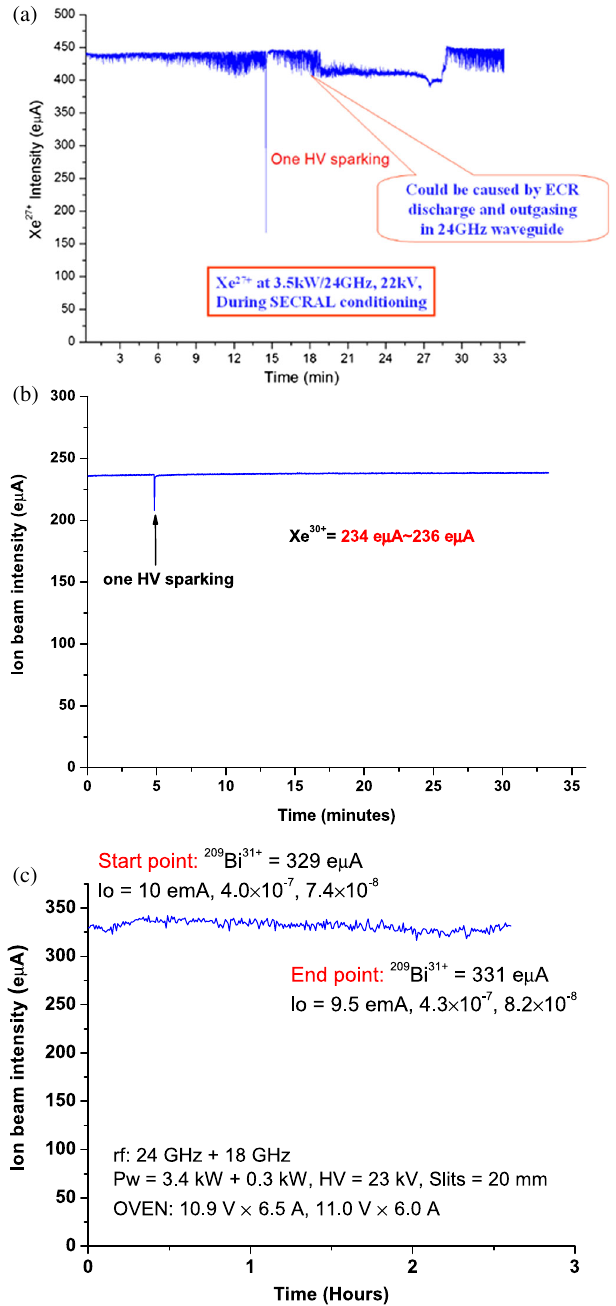
FIG. 27. SECRAL beam stability study. (a) Beam intensity instability of 129 Xe 27 þ at 435 e μ A when SECRAL was tested with single frequency 24 GHz heating at 3.5 kW power. (b) 129 Xe 30 þ beam intensity stability at 235 e μ A with 24 þ 18 GHz. (c) 209 Bi 31 þ beam intensity stability at 330 e μ A testing continuously during 2.5 hours.